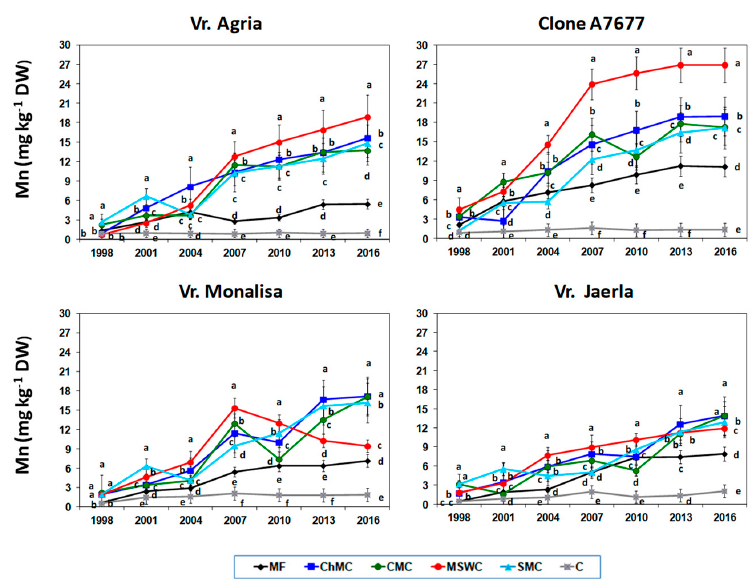
Figure 7. Evolution of iron content (mg kg − 1 DW) in potato tubers of the Agria, Monalisa, Jaerla and clone A7677 varieties (1998–2016) versus the application of compost from different organic amendments. The means with different lowercase letters within each season indicate significant differences between the treatments ( p < 0.001). Bars stands for standard deviations. MF: mineral fertilizer; ChMC: chicken manure compost; CMC: cow manure compost; MSWC: municipal solid waste compost; SMC: sheep manure compost; C: control.